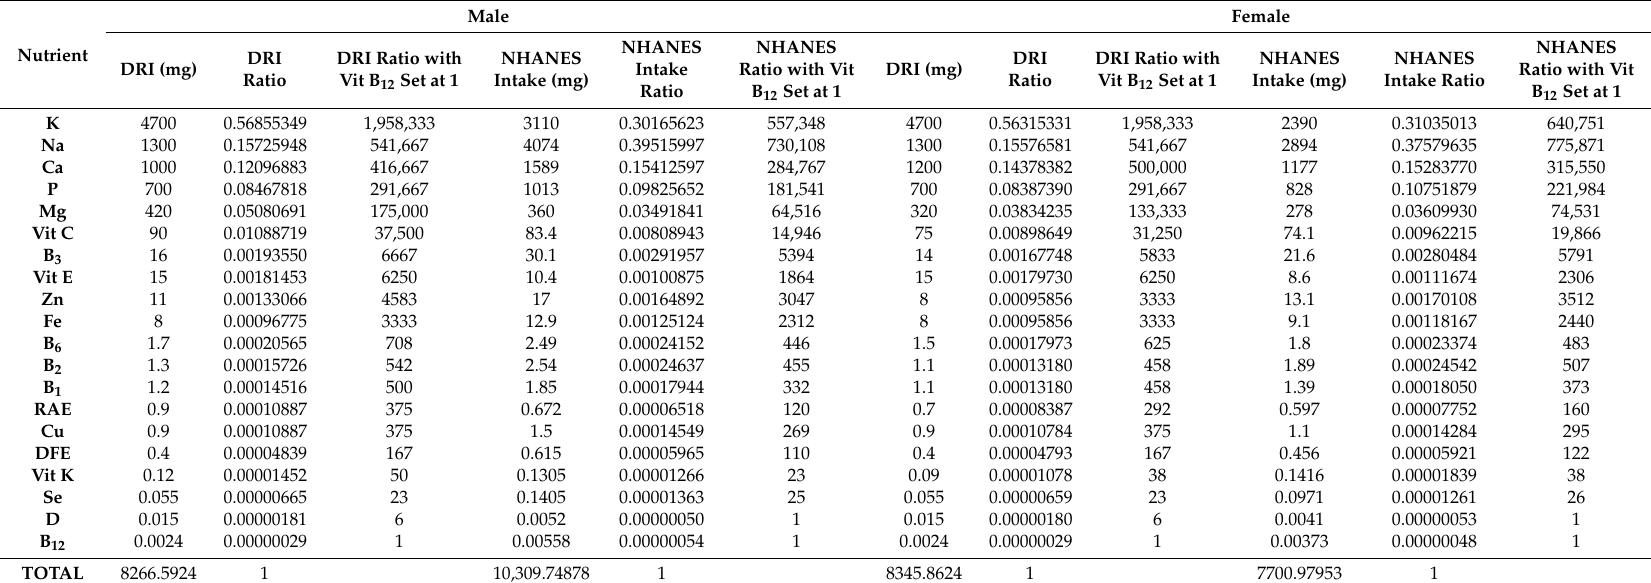
Table 5. Minerals and vitamins combined from Dietary Reference Intakes (DRI) for males and females 51–70 years and mean intakes from food derived from National Health and Nutrition Examination Survey (NHANES) 2013–2014 data for males aged 51–59 years, their ratios and ratios relative to vitamin B 12 .